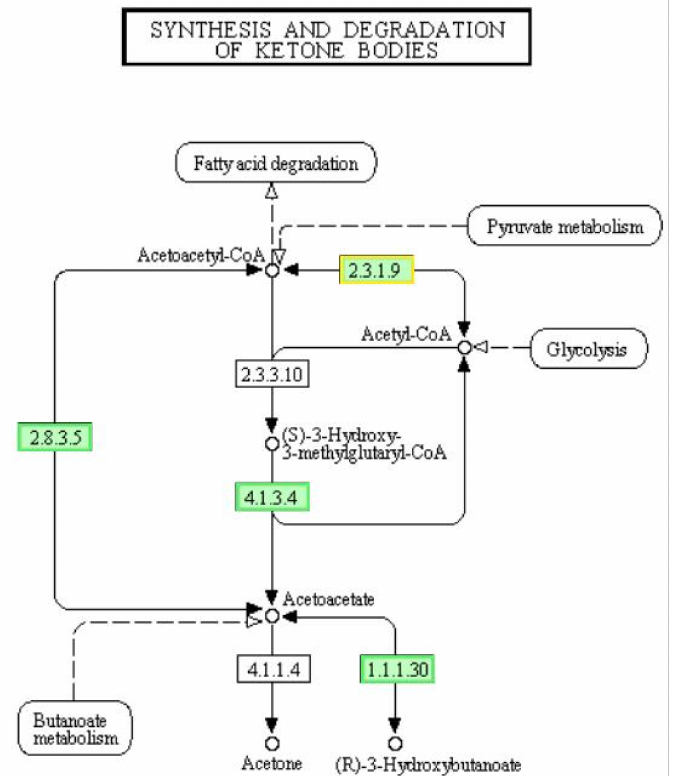
Figure 8. Significantly enriched KEGG pathway “Synthesis and degradation of ketone bodies”; (from KEGG database, green rectangles represent proved Organism-specific gene product and green frames represent down-regulation and red frames represent